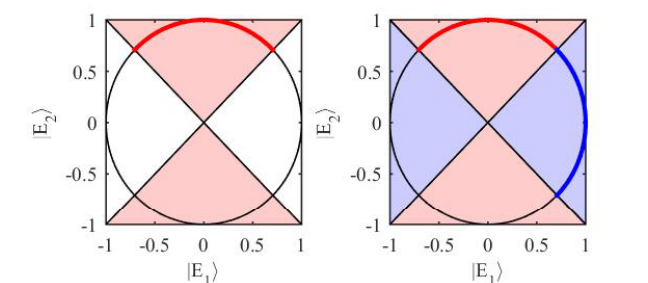
Figure 5. Left) In C 2 it is possible to select a cone that only captures half of the states with time